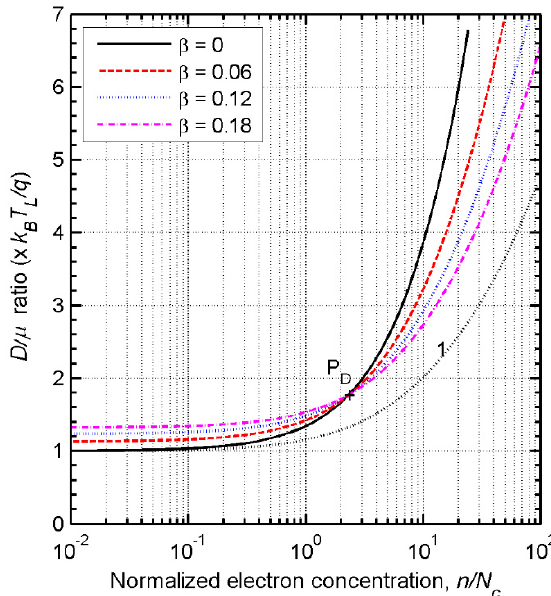
Figure 3. The same as in Figure 2, but as a function of the electron concentration normalized to the effective density of states (DOS), N c . The dashed curve 1 displays the D / μ ratio calculated with the existing formula, Equation (6), for β = 0.18.